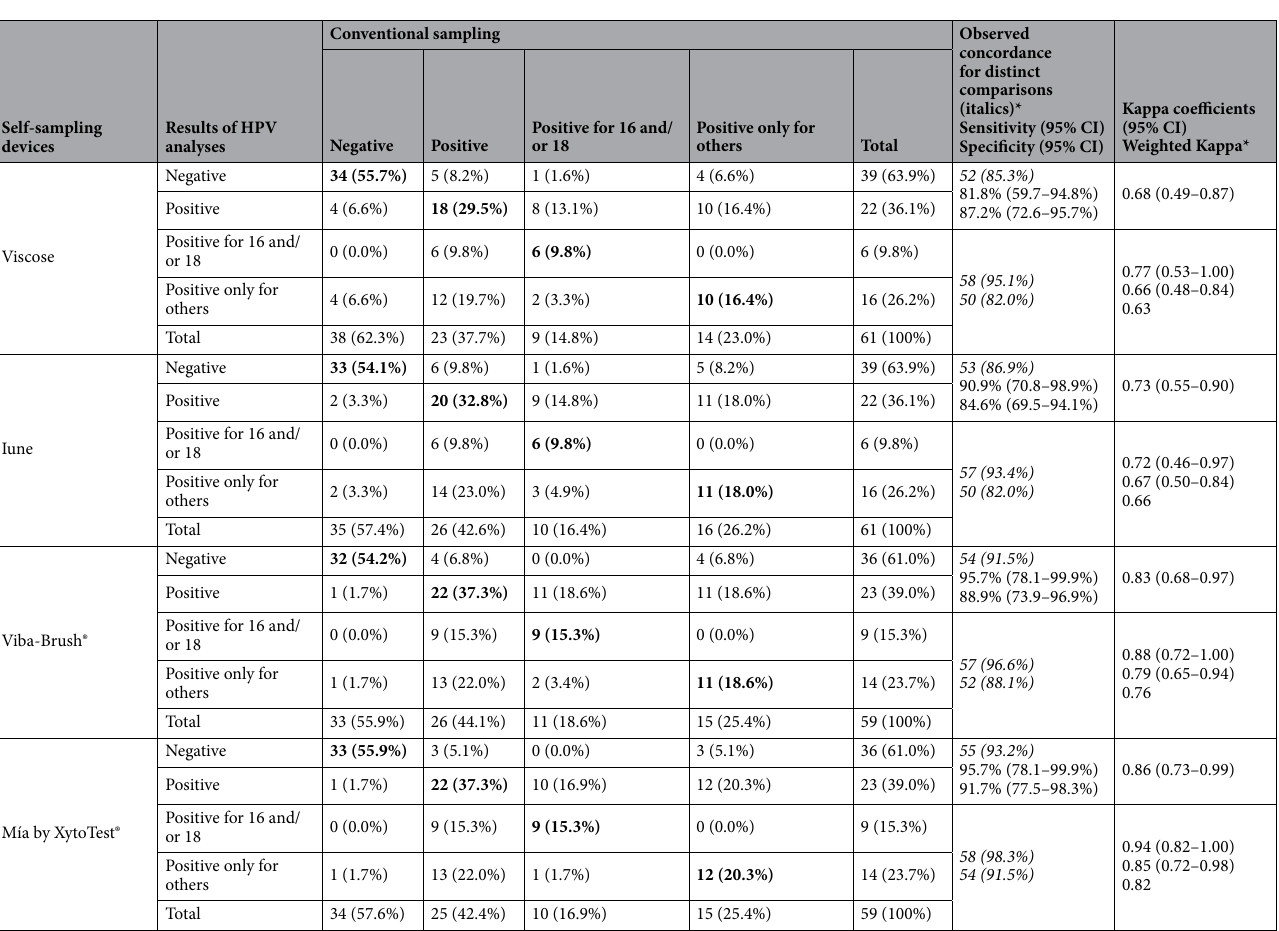
Table 4. Concordance of human papillomavirus analysis with the gold standard according to each device for self-sampling. Coincidental results between samples are in bold. HPV high-risk human papillomavirus, 95% IC 95% confidence interval. *The values corresponding to the comparison between positive and negative HPV tests are shown, later those HPV positive for types 16 and/or 18 versus the rest of the results and, finally, among the three possible categories (negative, positive for types 16 and/or 18, positive only for